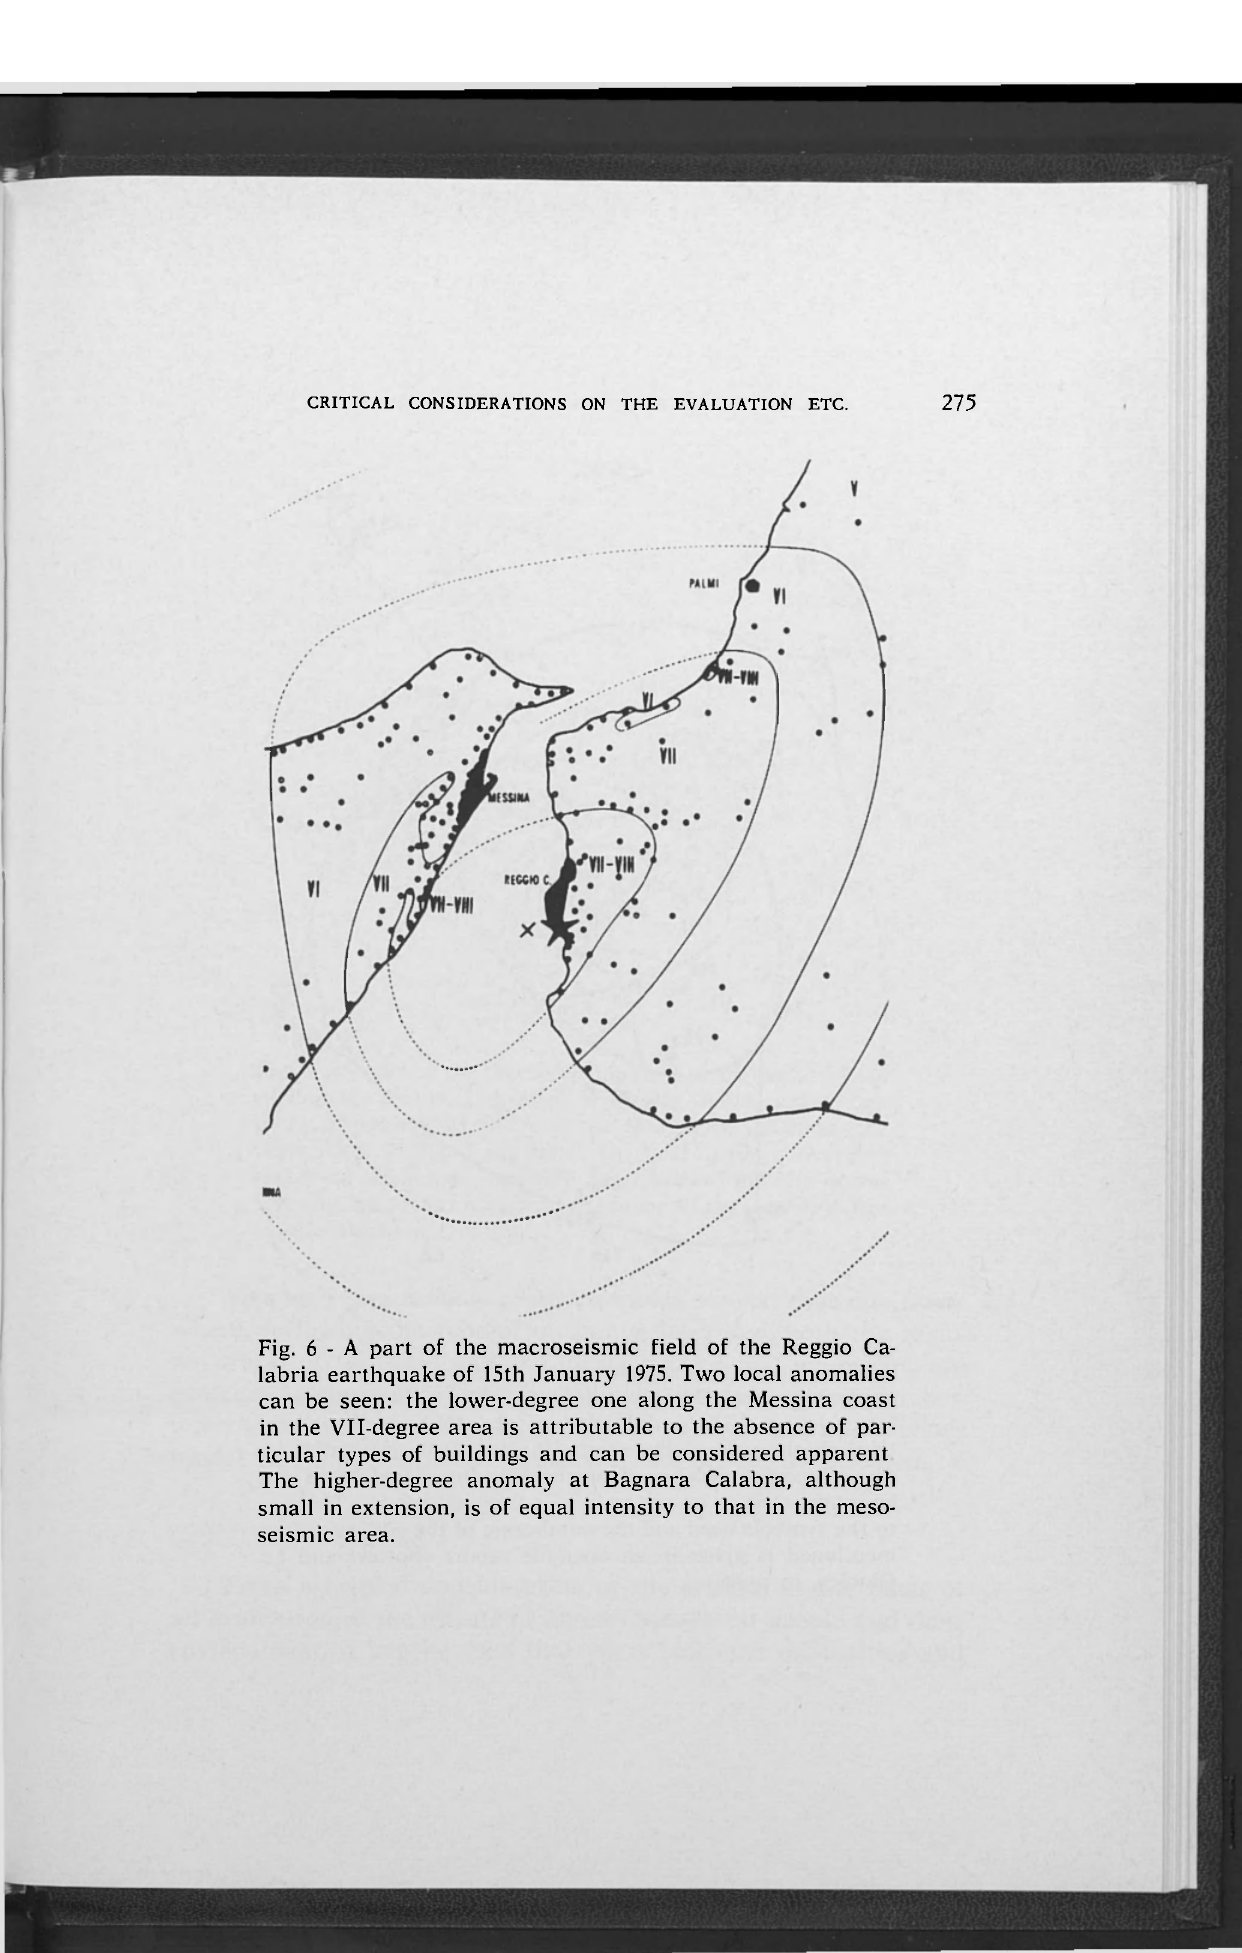
Fig. 6 - A part of the macroseismic field of the Reggio Ca- labria earthquake of 15th January 1975. Two local anomalies can be seen: the lower-degree one along the Messina coast in the VH-degree area is attributable to the absence of par- ticular types of buildings and can be considered apparent The higher-degree anomaly at Bagnara Calabra, although small in extension, is of equal intensity to that in the meso- seismic